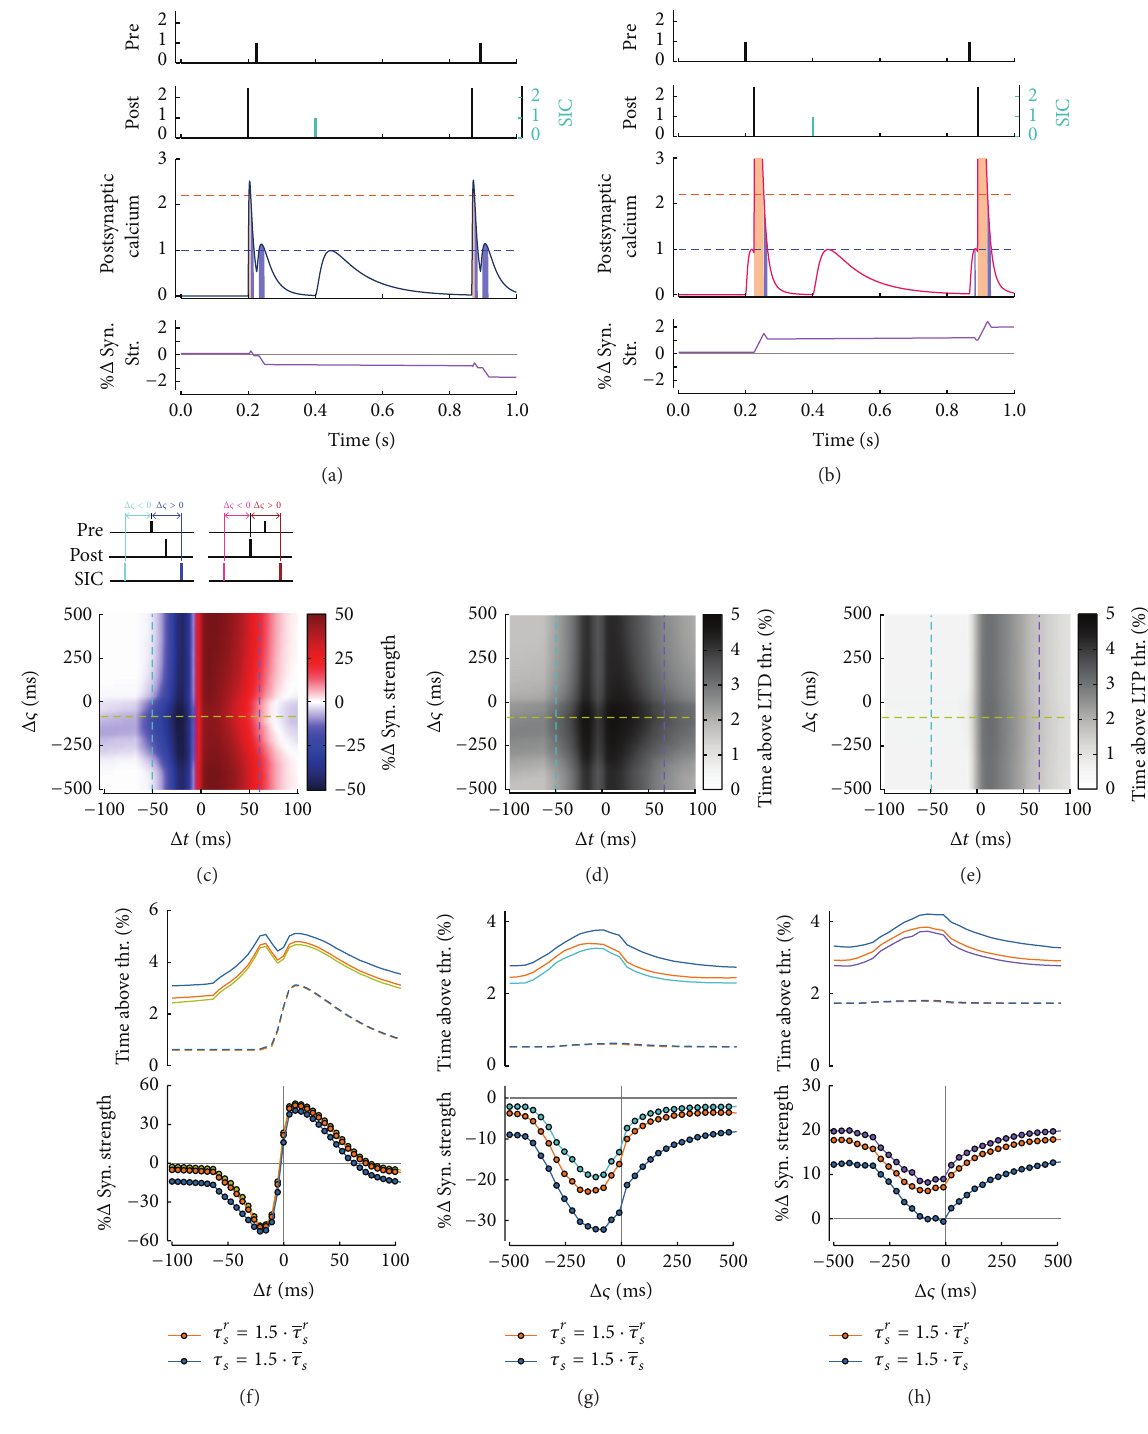
Figure 8: Effect on STDP of SIC timing with respect to pairings. ((a), (b)) Impact on plasticity of a SIC occurring 0.2 ms after the first pairing instead of 0.1 s before it as previously considered in Figures 7(a), 7(b). (c) STDP curves as a function of the SIC pre/post pair delay ( Δ𝜍 ) show how LTD could get stronger while the LTP window shrink for small-to-intermediate Δ𝜍 ≤ 0 in correspondence with ((d), (e)) a maximum of the duration of Ca 2+ transients above the LTD threshold. These results were obtained assuming SIC rise and decay time constants, respectively, equal to 𝜏 𝑟 𝑠 = 𝜏 𝑟 𝑠 = 20 ms and 𝜏 𝑠 = 𝜏 𝑠 = 200 ms. ((f), (h)) Peak and range of this LTD increase ultimately depend on SIC kinetics as reflected by the change of sample curves for specific Δ𝜍 ( yellow curve ) and spike-timing intervals ( cyan and purple curves ) when SIC rise and/or decay time constants were slowed down 1.5-fold ( orange and blue curves, resp.). ((c), (h)) The same pairing protocol of Figures 7(c) and 7(d) was used but with a SIC frequency of 0.2Hz and variable SIC onset and kinetics according to Δ𝜍,𝜏 𝑟 𝑆 , and 𝜏 𝑆 . Parameters as in Figure